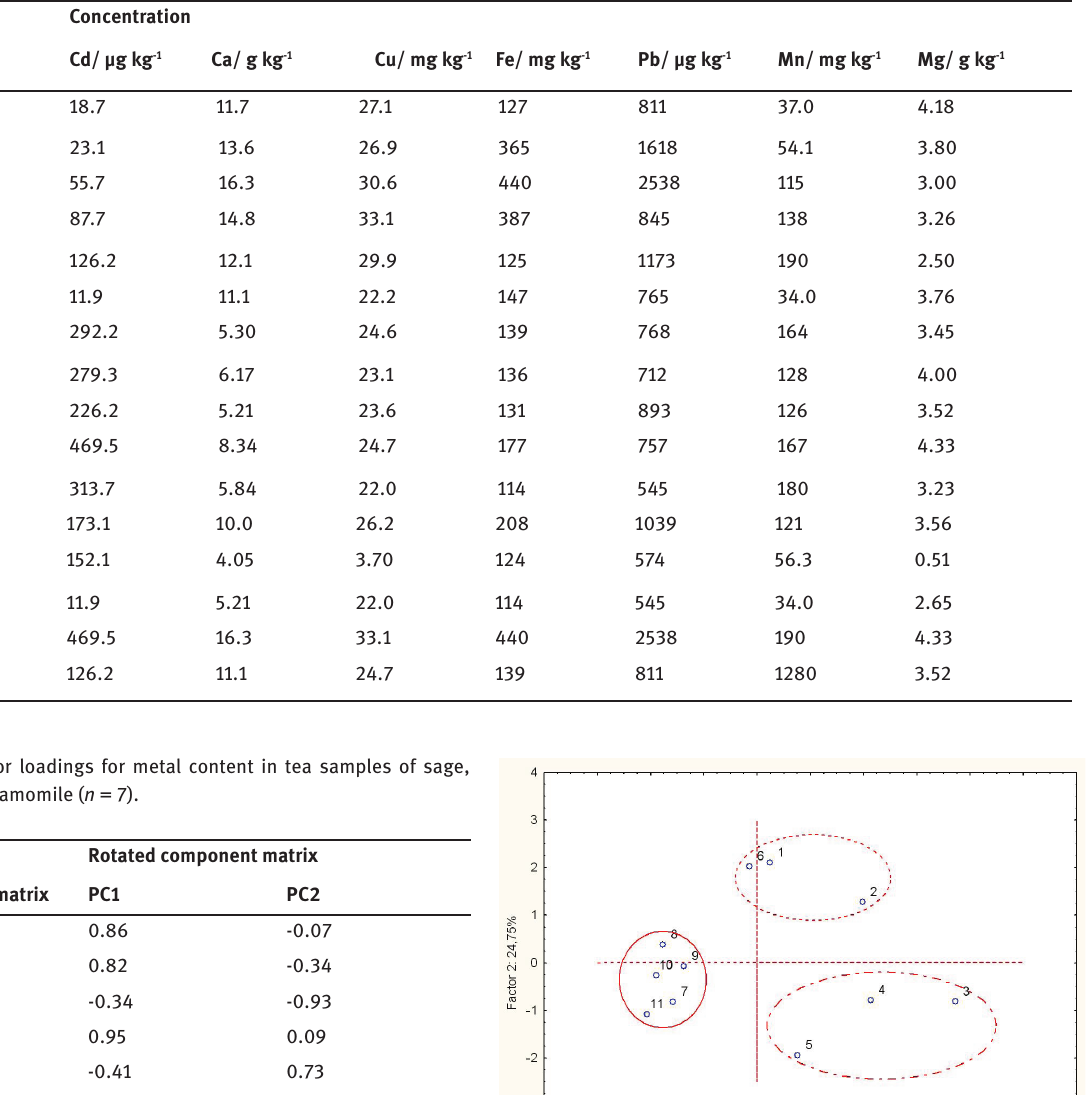
Table 4: Elemental content in analyzed tea samples expressed as mass of metal per kg of dry input sample (mean of three measurements). Sample Concentration